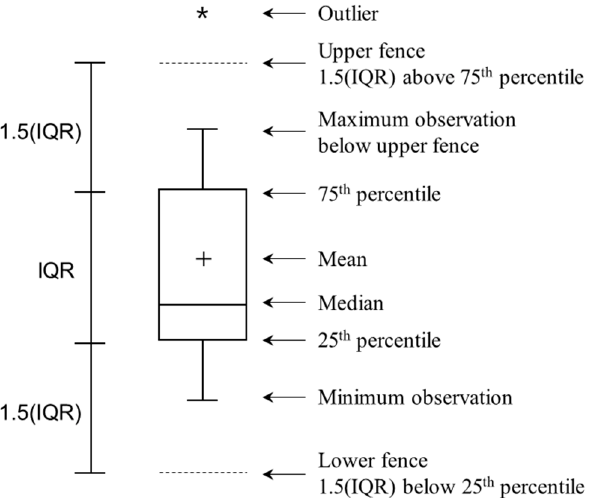
Figure 6. Concept of the box plot in statistical analysis.